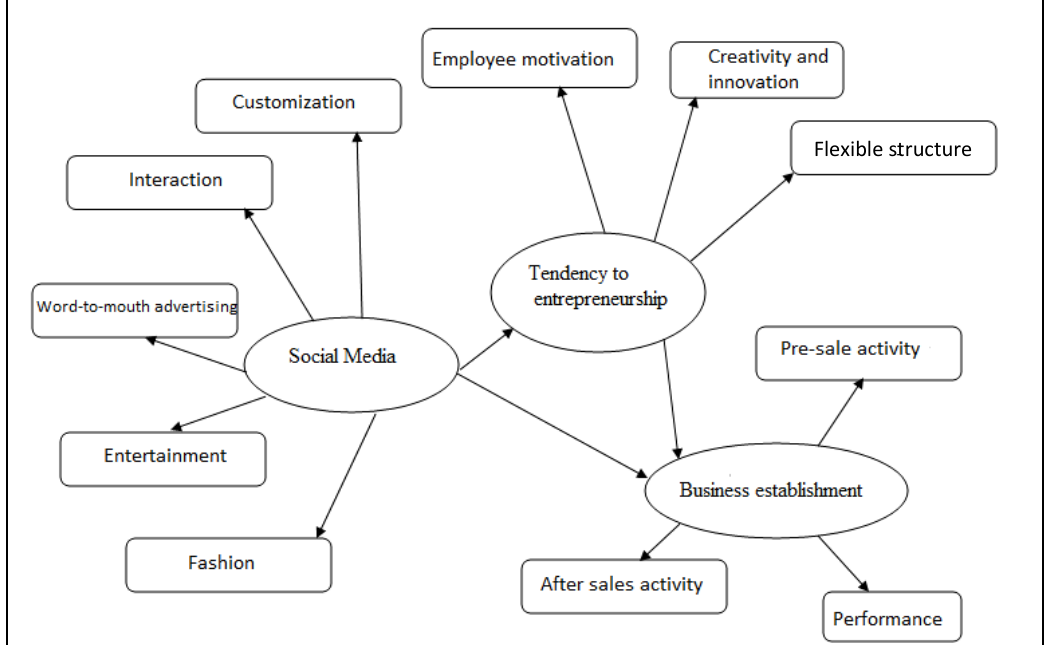
Figure 1. Conceptual Model [6, 8]